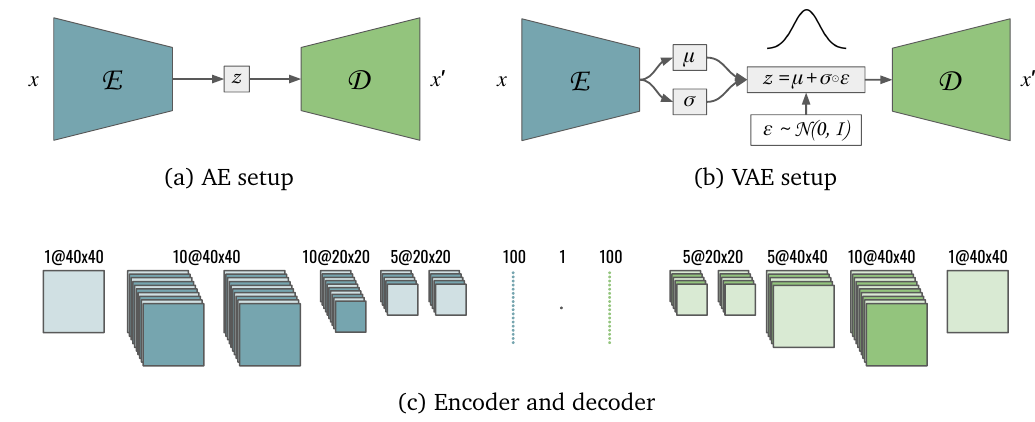
Figure 2: Architectures used for the AE and VAE networks in this study. All convo- lutions use a 5x5 kernel size and all layers use PReLU activations. Downsampling from 40x40 to 20x20 is achieved by average pooling, while upsampling is nearest neighbor